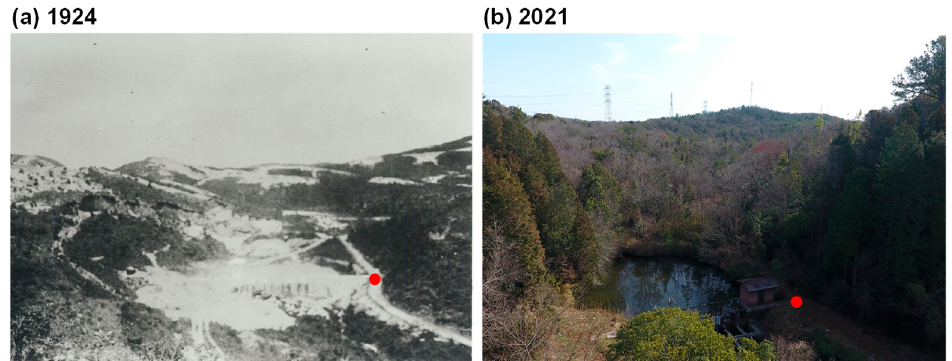
Figure 1. Study area. Map of Japan and Aichi prefecture were drawn via the software R v.4.0.3 using packages “maps”, “mapdata”, and “mapproj”. Map of AEF and contours were obtained from the archives of the Ecohydrology Research Institute [28].